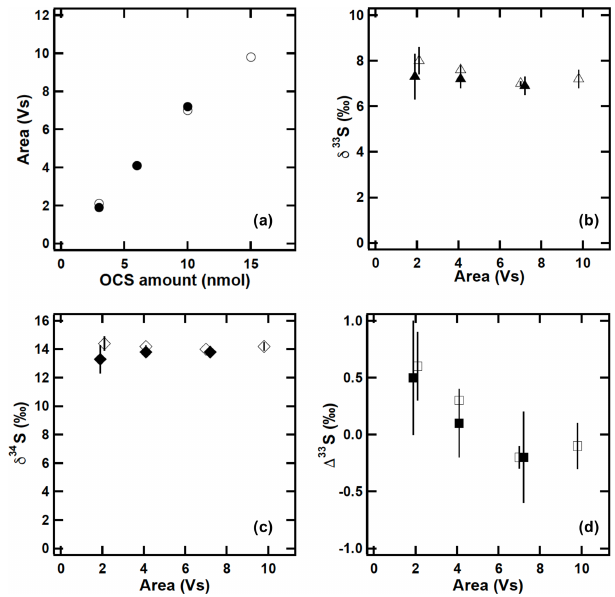
Figure 4. OCS amounts and sulfur isotope ratios of differ- ent amounts of OCS injections ascertained using the developed sampling–purification system and conventional syringe injection system (Hattori et al., 2015): (a) OCS amount; (b) δ 33 S; (c) δ 34 S; (d) (cid:49) 33 S; closed symbols, sampling–purification system developed for this study; open symbols, conventional syringe injection system. All sulfur isotope ratios are relative to VCDT. The error bars are 1 σ of the measurements based on triplicated